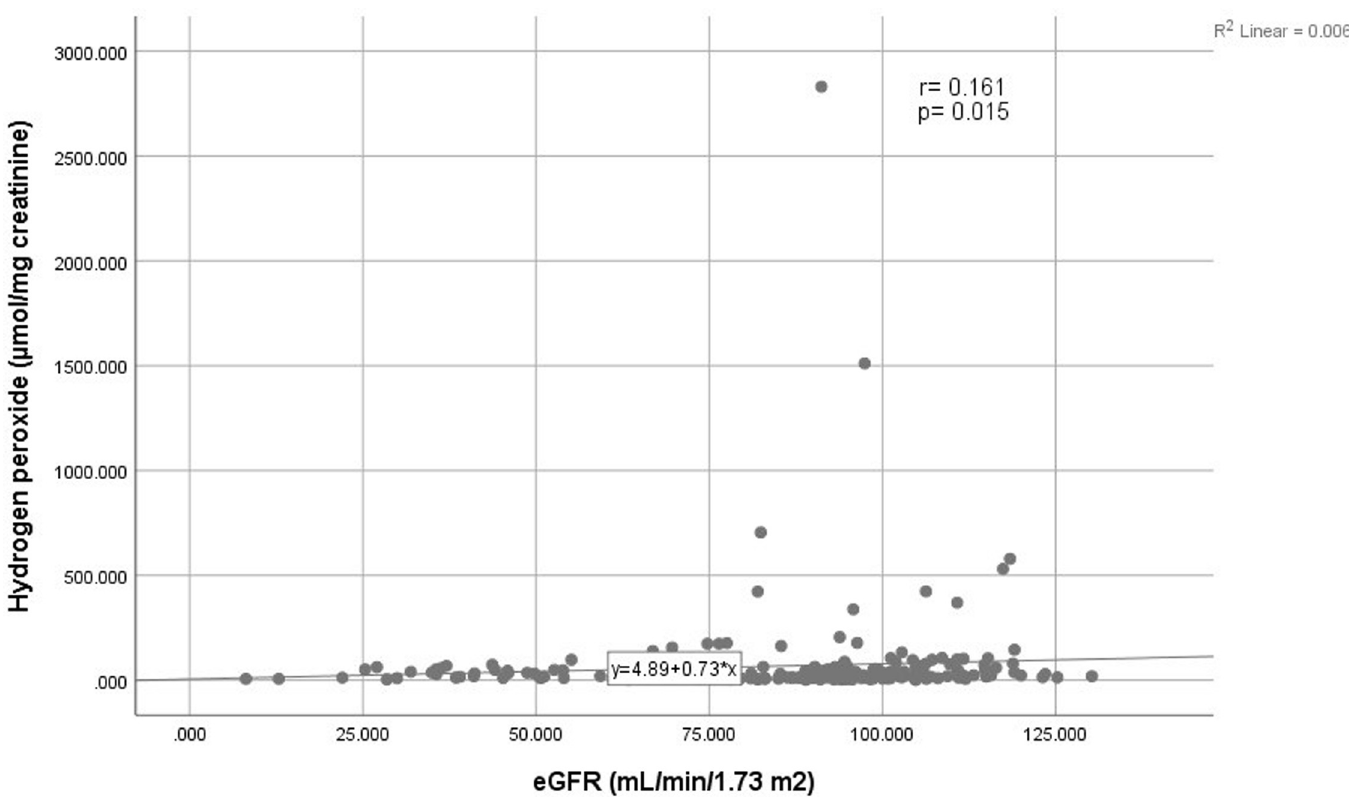
Fig 1. Scatter plot for the correlation between eGFR with urine H 2 O 2 in total population (n = 227).